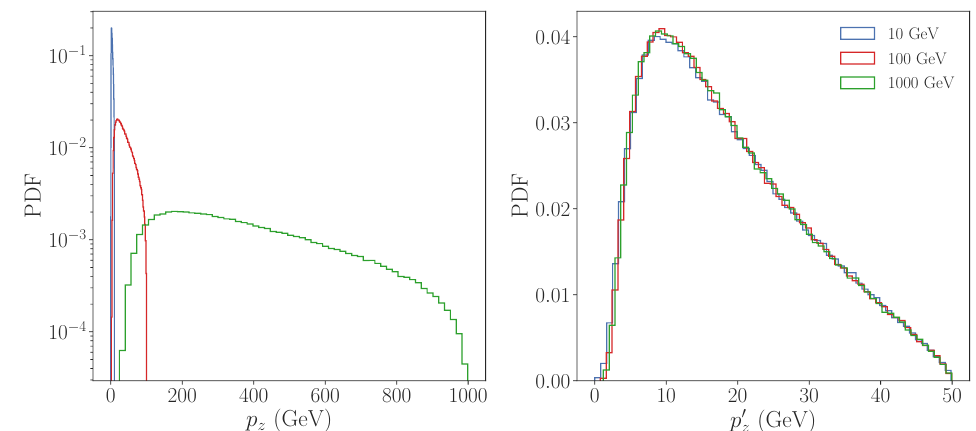
Figure 2: The p distributions (left) and the rescaled p ′ z from P YTHIA hadronization events for the first-hadron emission with initial parton energies E = 10,100,1000 GeV shown with blue, red, and green solid lines, respec-